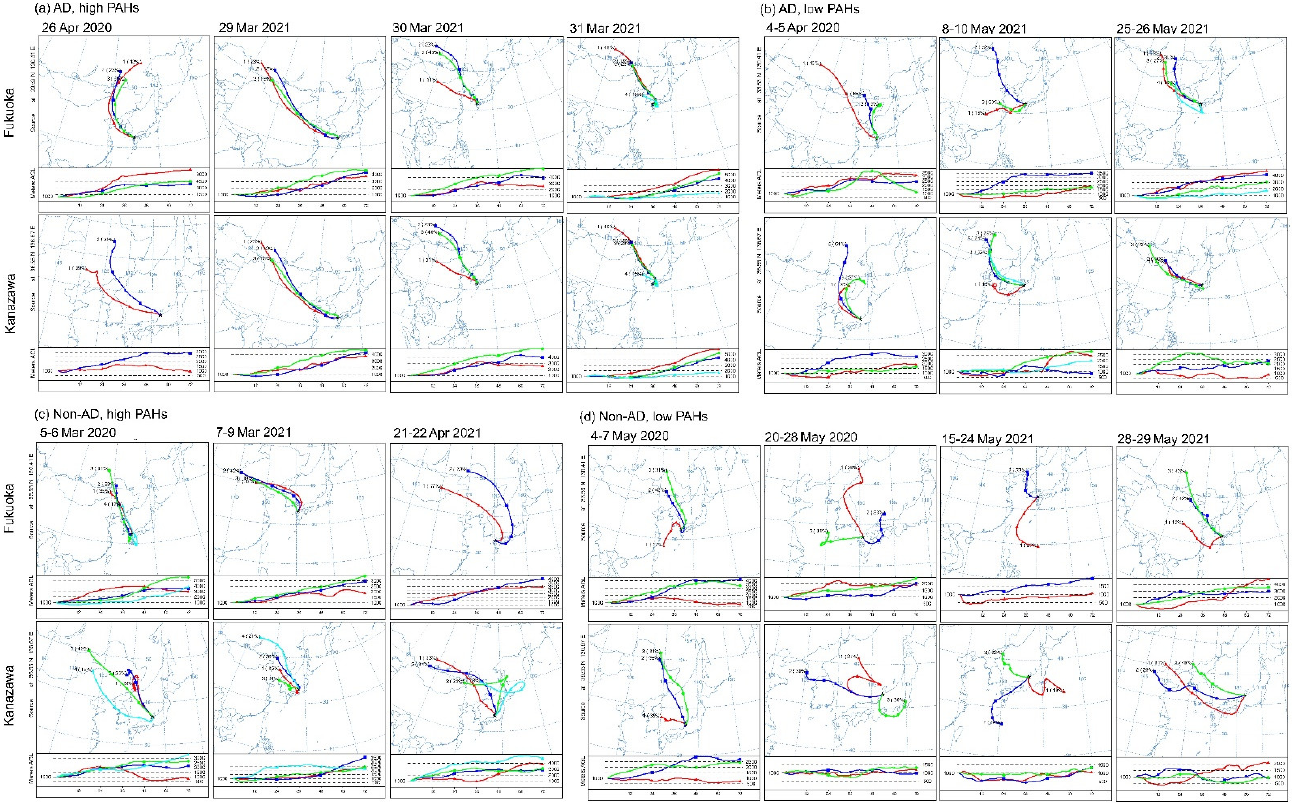
Figure 3. The backward trajectory and cluster analysis of four patterns: ( a ) AD days with high PAH concentration ( ≥ mean PAH concentration in AD days: 0.85 ng m − 3 in Fukuoka and 0.43 ng m − 3 in Kanazawa), ( b ) AD days low PAH concentration (<mean PAH concentration in AD days), ( c ) non-AD with high PAH concentration ( ≥ mean PAH concentration in non-AD days: 0.76 ng m − 3 in Fukuoka and 0.28 ng m − 3 in Kanazawa), and ( d ) non-AD days with low PAH concentrations (<mean PAH concentration in non-AD